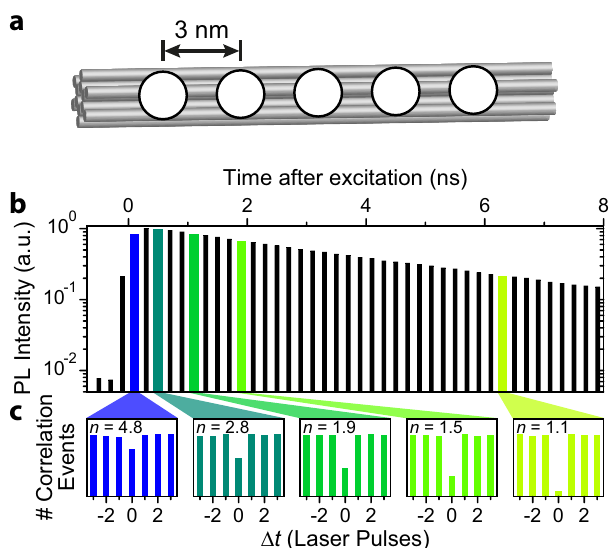
Fig. 2 Tracking exciton diffusion and annihilation in space and time on a well-de fi ned multichromophoric DNA origami structure. a Schematic of a short part of a 225 nm long 12-helix-bundle DNA origami structure with 6 inner and 6 outer helices. Five dyes (white discs) can be positioned at 3 nm spacing from each other. b Measured photoluminescence (PL) decay of a single DNA origami structure with fi ve ATTO647N dye molecules. A single-exponential decay is observed with a PL lifetime of ~4.2 ns. Panel c shows fi ve corresponding photon statistics histograms for different microtime bins (0 – 200, 200 – 400, 800 – 1000, 1600 – 1800 and 6400 – 6600 ps) in terms of the photon correlation events, N , of the two photodetectors. Data were accumulated for 54 single mcNPs. The number of independent chromophores, n , determined from the correlation histogram for each microtime bin is stated above the